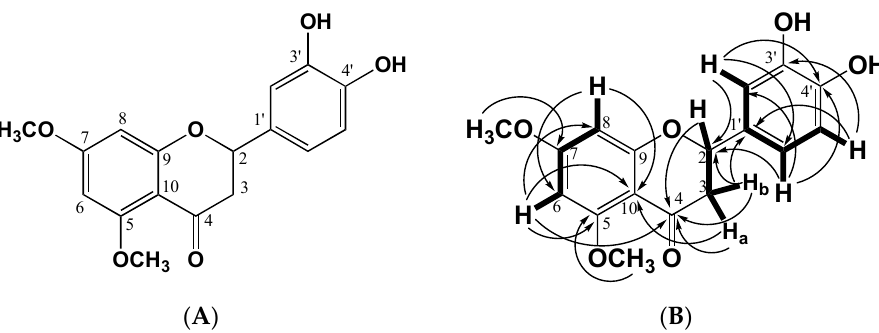
Figure 1. The structure of 3 ′ ,4 ′ -dihydroxy-5,7-dimethoxyflavanone (Tacotanina). ( A ) Molecular structure. ( B ) Key COSY (bold) and HMBC (H → C) correlations for the compound. Table 1. 1 H NMR and 13 C NMR (300 MHz, Acetone-d 6 ) spectral data for the flavonoid Tacotanina.